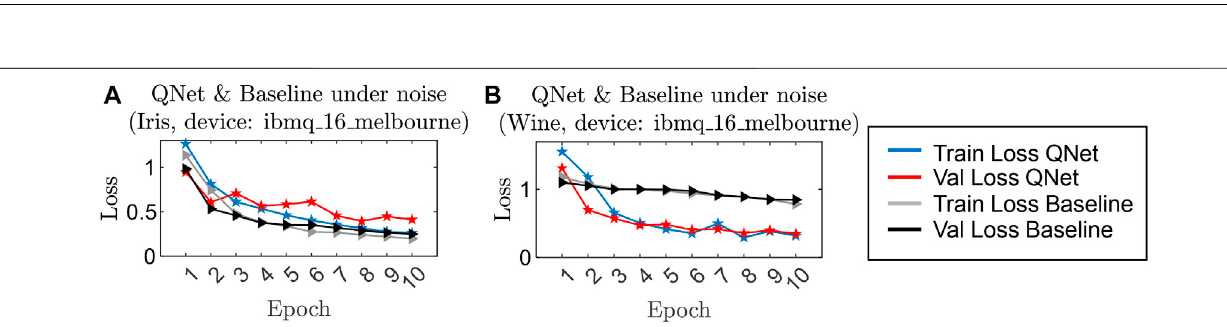
FIGURE 6 | QNet and Baseline model performances in 10 training epochs on a simulator (noiseless) with similar network sizes (same number of trainable circuit parameters). (A,B) shows the performances on Iris and Wine datasets, respectively. These models exhibit similar performances in noiseless simulations.